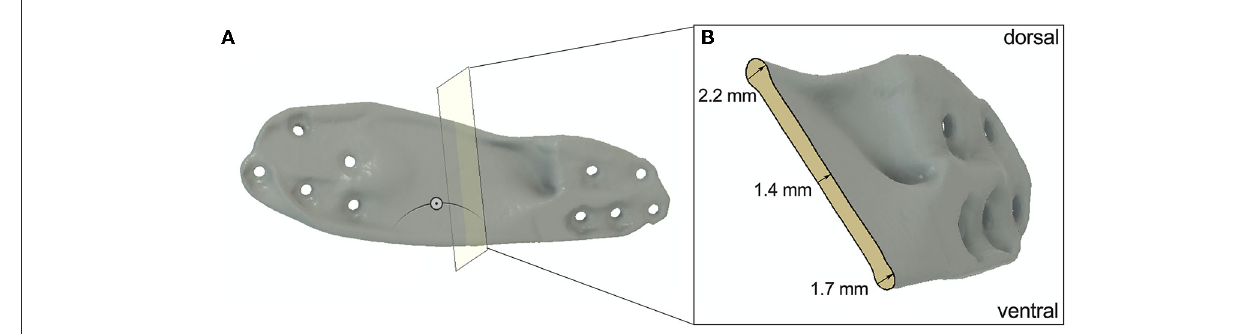
FIGURE2 (A) Section analysis of D4 to show the thickness of the midsection of the plate. (B) Cross section of D4.